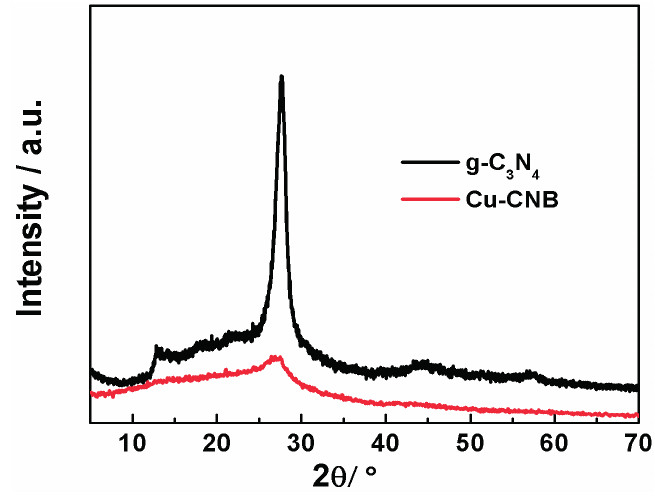
Figure 2. The XRD patterns of the